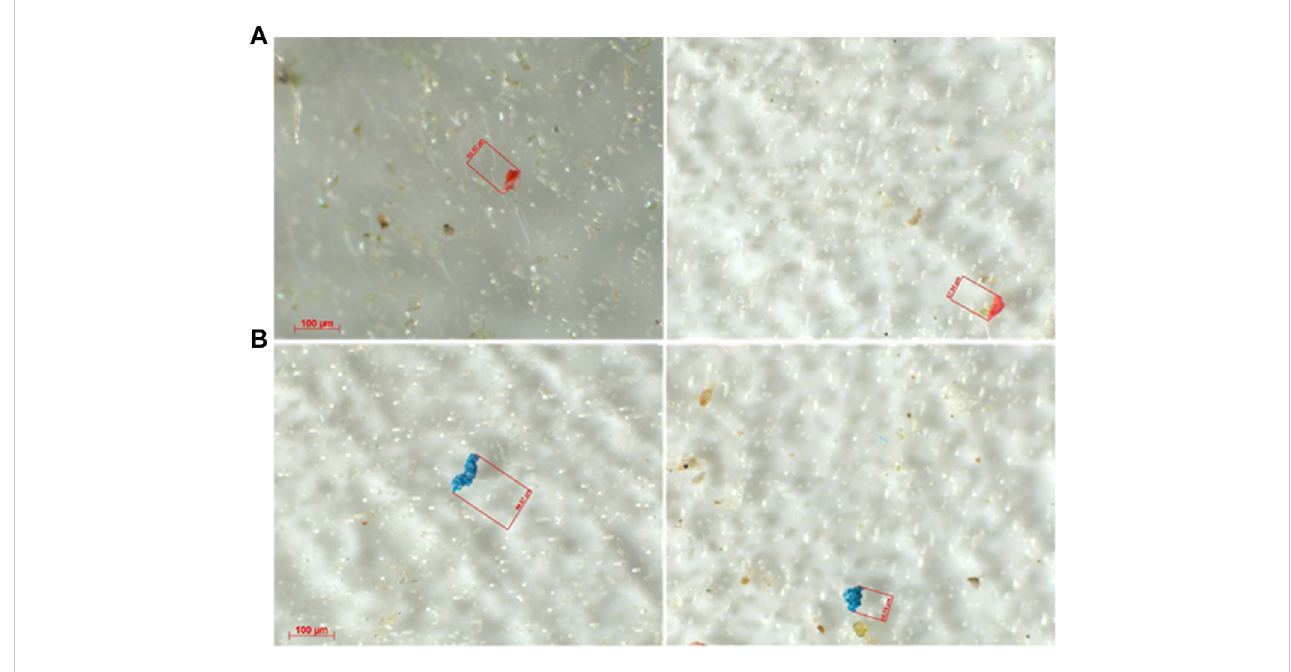
FIGURE 4 Examples of red (A) and blue (B) particles detected with LM in fi ltration samples.